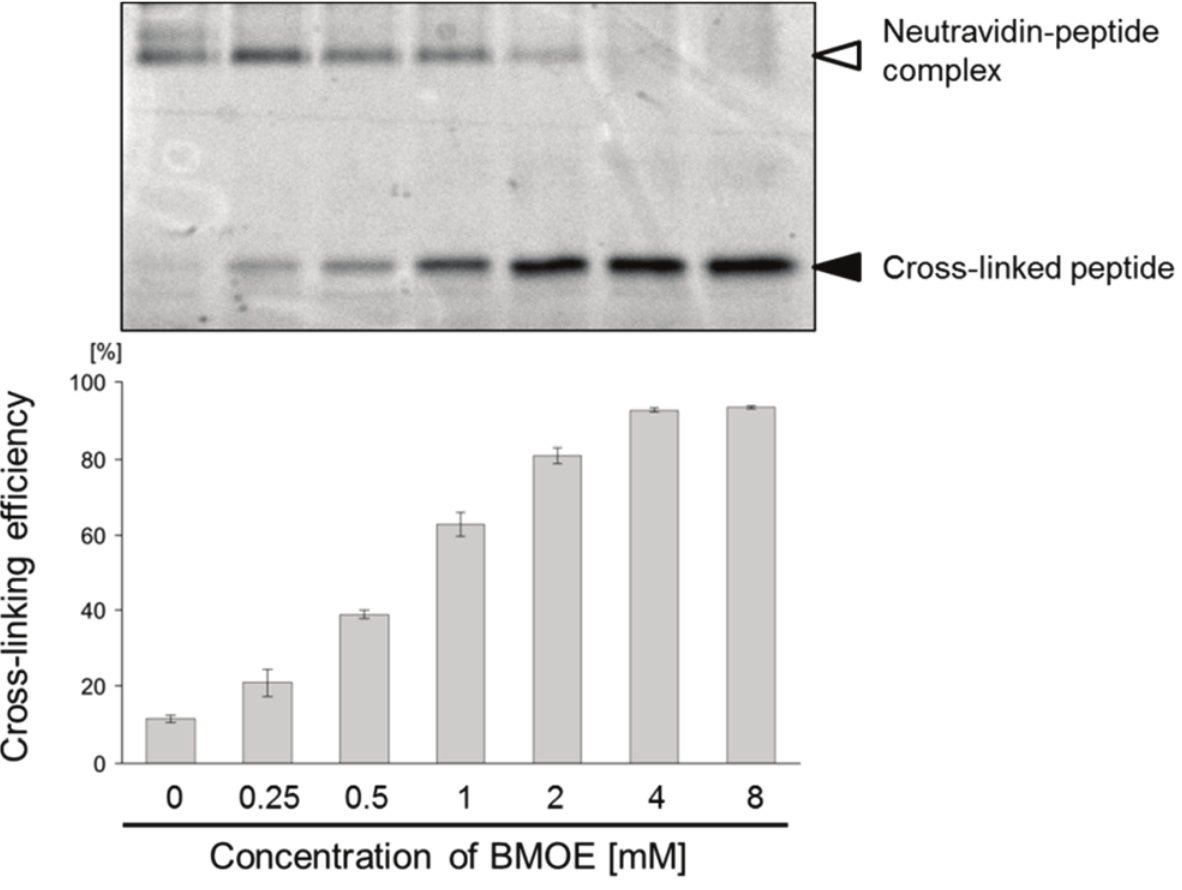
Figure 4. Optimization of the conditions for introducing a chemical cross-linker into the Cys2-6 peptide. Cys2-6 peptide, which was reacted with each concentration of BMOE, was analyzed by SDS-PAGE as described in Figure 2 (Upper). The cross-linking efficiencies of Cys2-6 peptide are indicated as the percentage of the band intensity of the unshifted Cys2-6 peptide against that of the total Cys2-6 peptide (Lower). Experiments were repeated 3 times. Error bars = standard